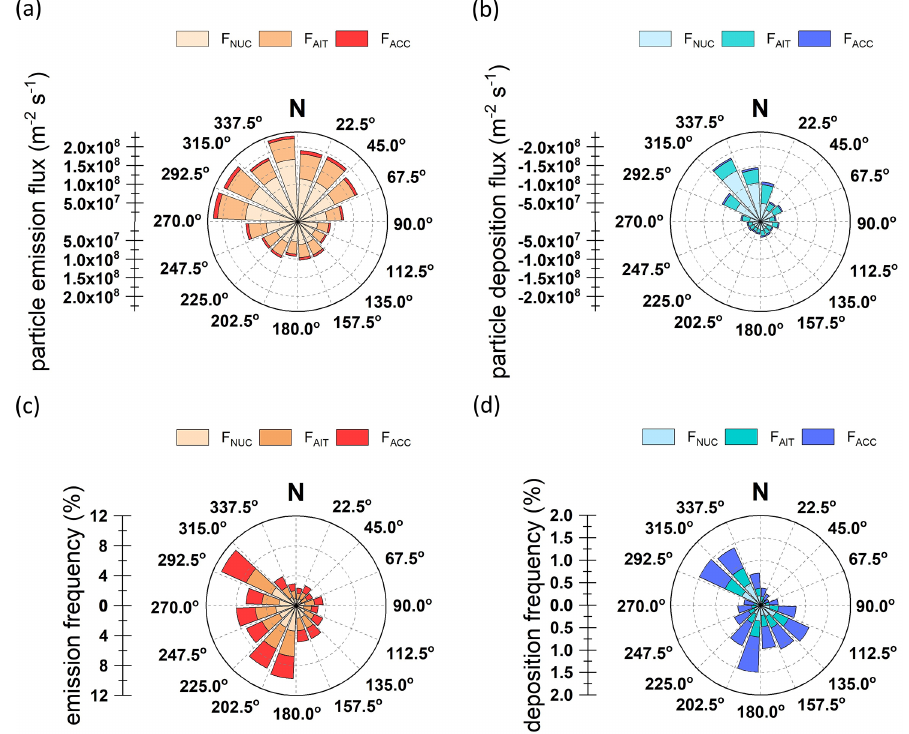
Figure 12. Average (a) emission and (b) deposition particle number fluxes as well as the frequencies of (c) emission and (d) deposition events per wind direction sector for F NUC , F AIT , and F ACC .